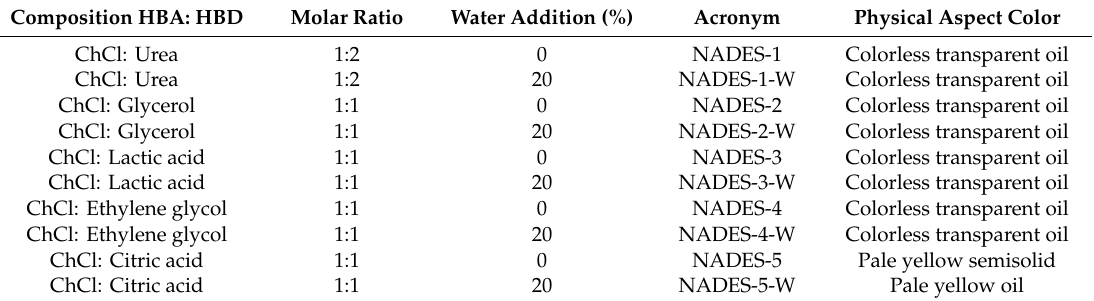
Table 1. Compositions and abbreviations for the prepared